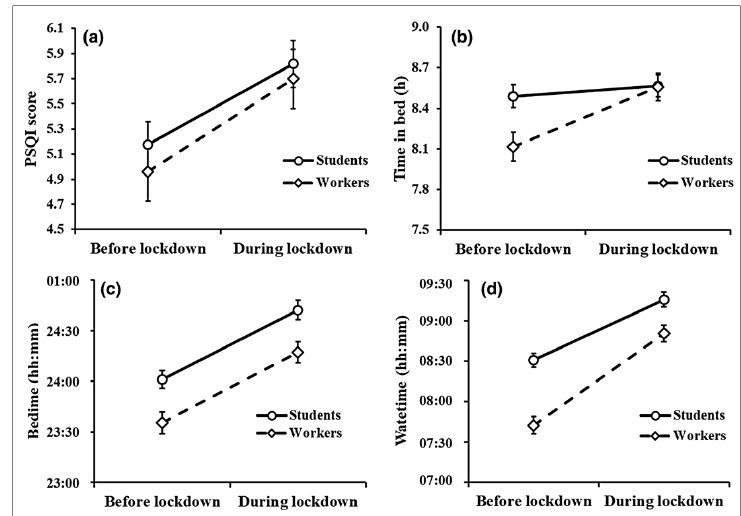
Figure 1. Changes in ( a ) Pittsburg Sleep Quality Index (PSQI) total score, ( b ) time in bed, ( c ) bedtime, and ( d ) wake time as a function of the presence of the lockdown and the status (worker or student) of the participants [9]. Reproduced with permission, 2020 European Sleep Research.